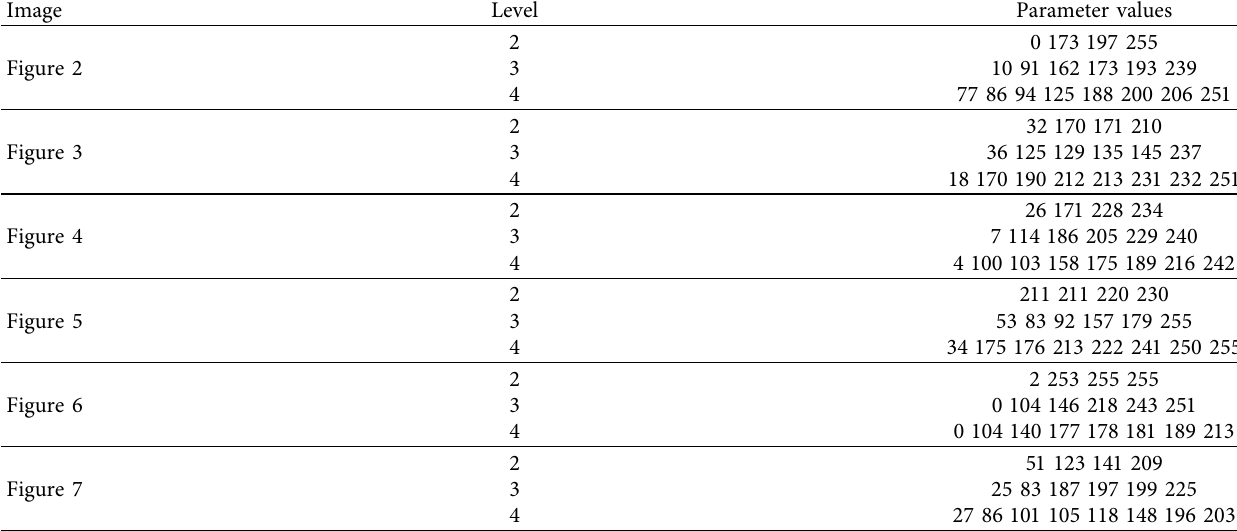
Table 1: Parameter values obtained using DE for 2–4 level thresholds of the proposed approach.